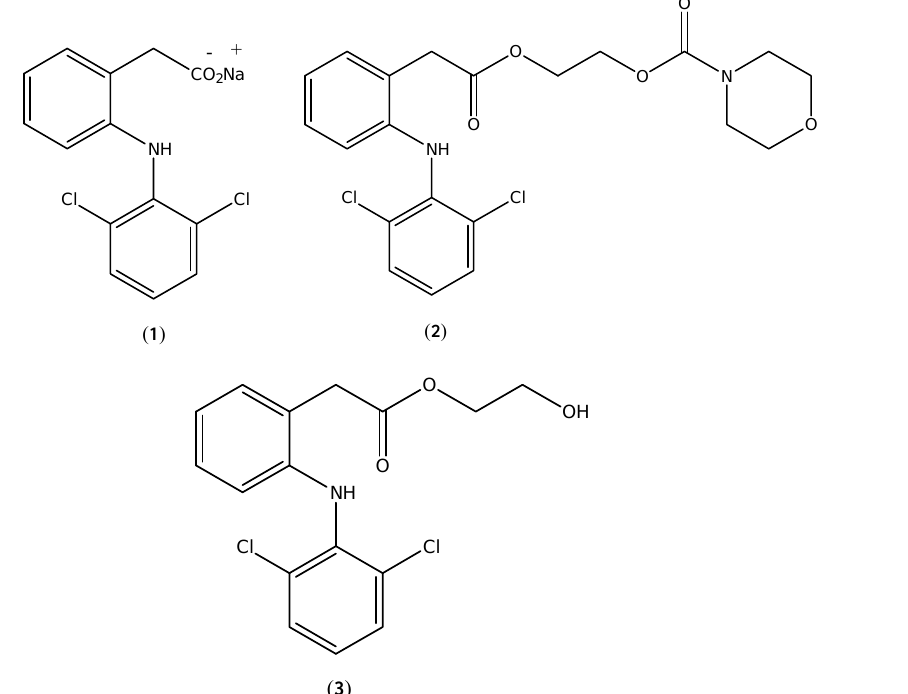
Figure 1. Chemical structures of diclofenac sodium ( 1 ), prodrug ( 2 ) and hydroxyethyldiclofenac ( 3